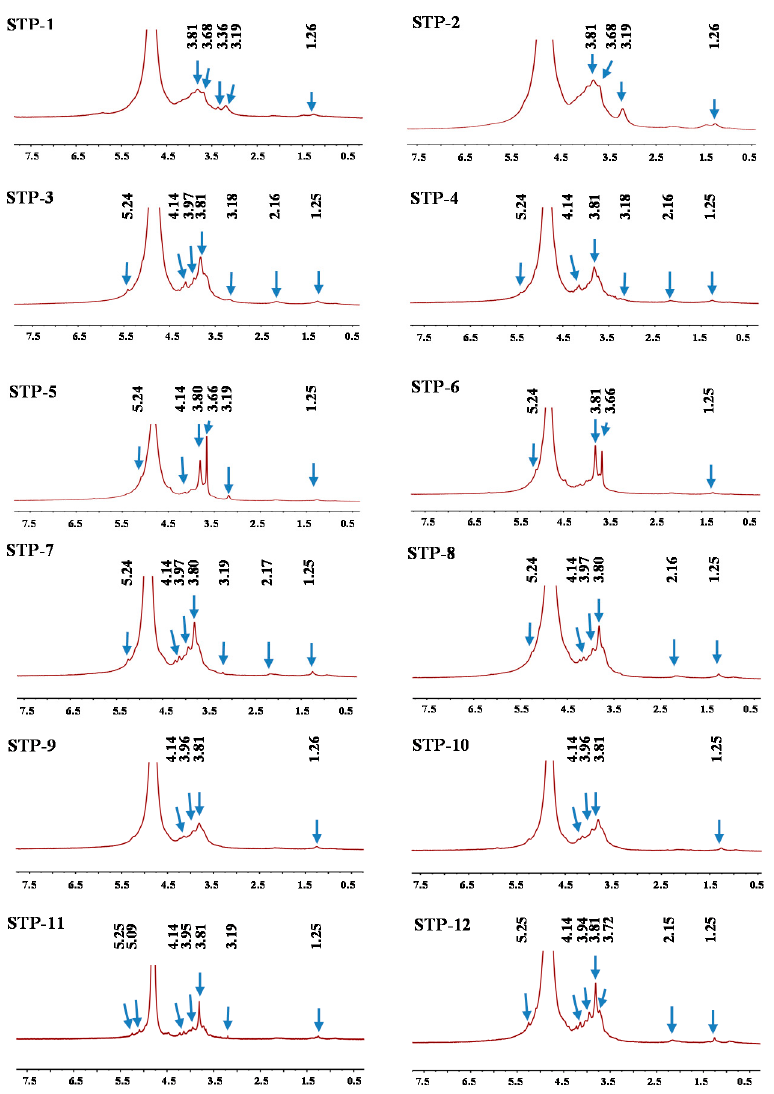
Figure 2. 1 H NMR spectra of TPs. TPs 1–12 represent tea polysaccharides as shown in Table 1.